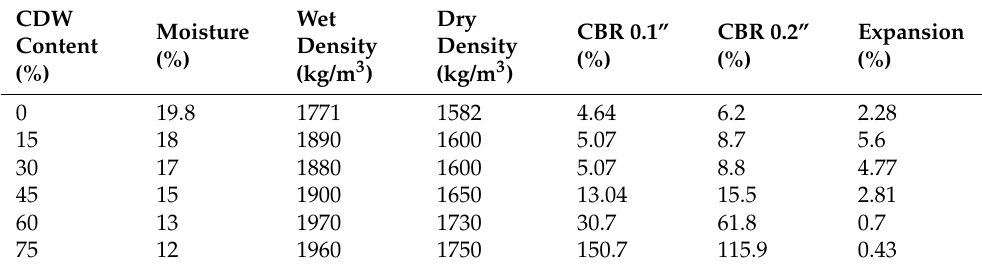
Table 5. CBR Results with normal Proctor energy in soil mixes with brick CDW.